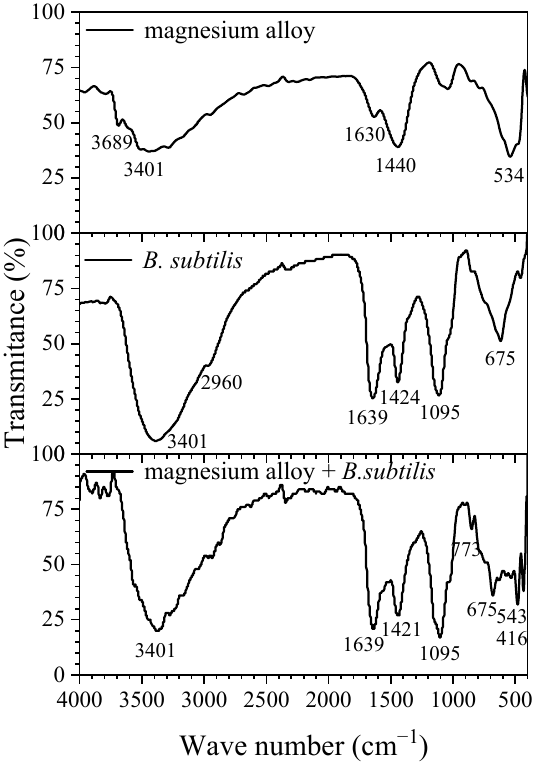
Figure 8. FTIR spectra of AZ31B magnesium alloy, B. subtilis , and AZ31B magnesium alloy with inoculation of B. subtilis at 48 h.